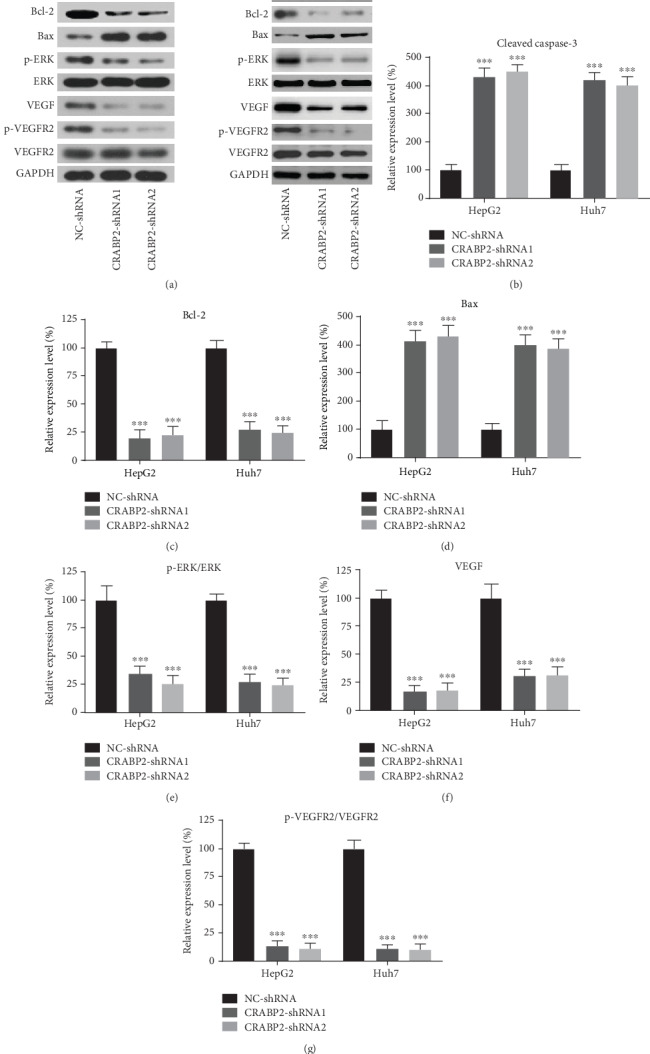
Effects of CRABP2 on ERK-VEGF pathway. (a)Western blotting results of ERK-VEGF pathway-related proteins and apoptosis-related proteins of HpeG2 and Hun7 cells. Expression of cleaved caspase-3 (b) and Bax (d) was increased, while Bcl-2 (c), p-ERK/ERK ratio (e), VEGF (f), and p-VEGFR2/VEGFR2 (g) decreased after CRABP2-shRNAs transfection in HpeG2 and Hun7 cells. n = 7. One-way ANOVA was used in multigroup comparison. All data are presented as mean ± SEM. ∗∗P < 0.01, ∗∗∗P < 0.001 vs. NC-shRNA.